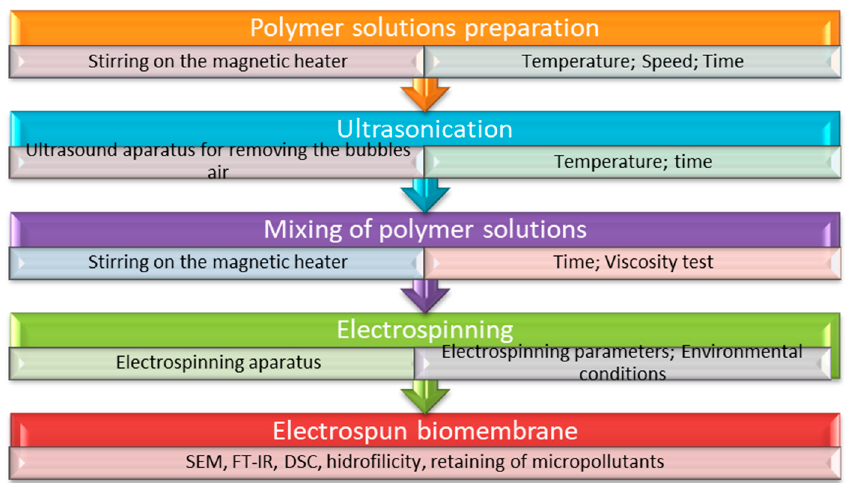
Figure 2. Electrospinning process steps applied for membrane fabrication.